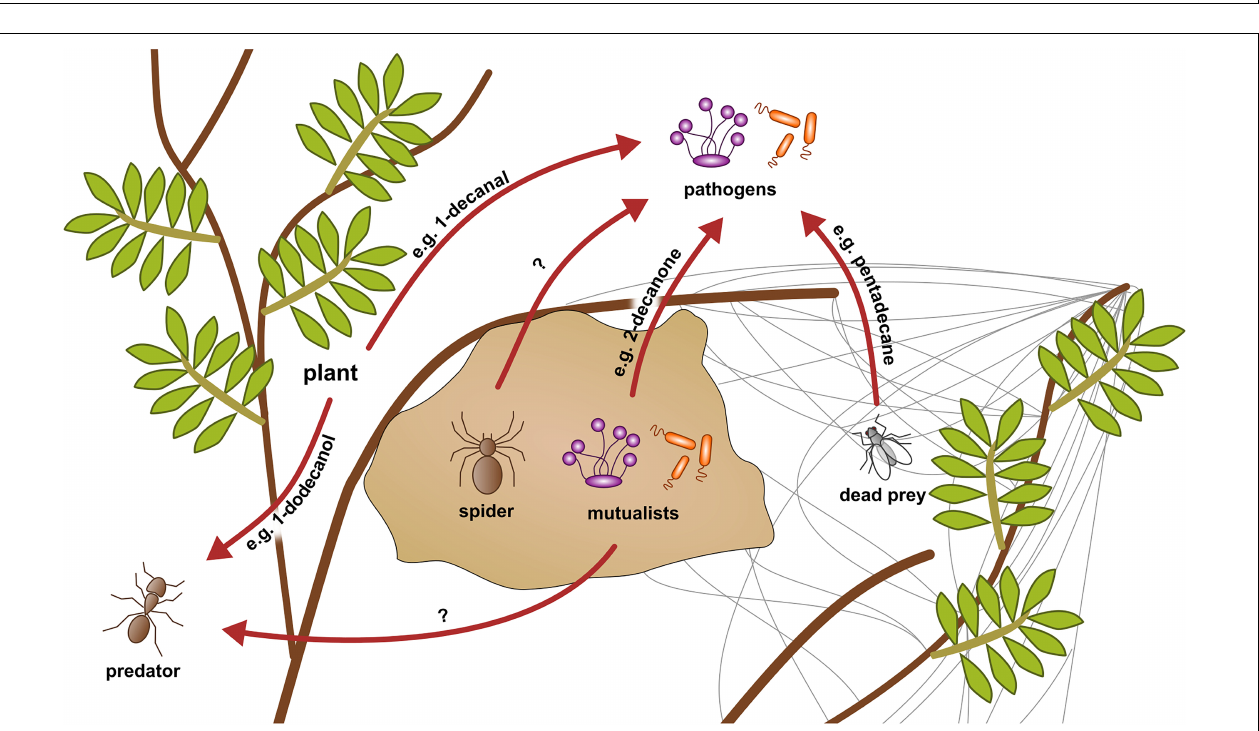
FIGURE 4 | Comparison of the volatilomes of the sampling sites Otavi, Windhoek, and Stampriet using Euler diagrams. The diagrams are based on all identified and unknown VOCs of the nests (A) , webs (B) , and spiders (C) . The areas are proportional to the number of VOCs.